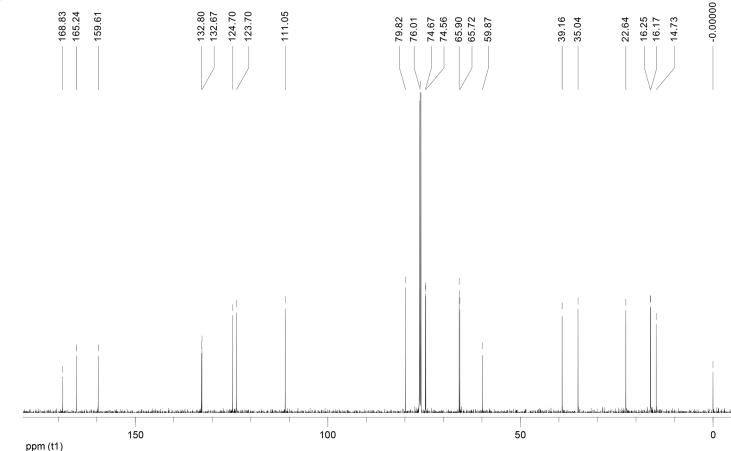
13C NMR (CDCl3) spectrum of compound 5.